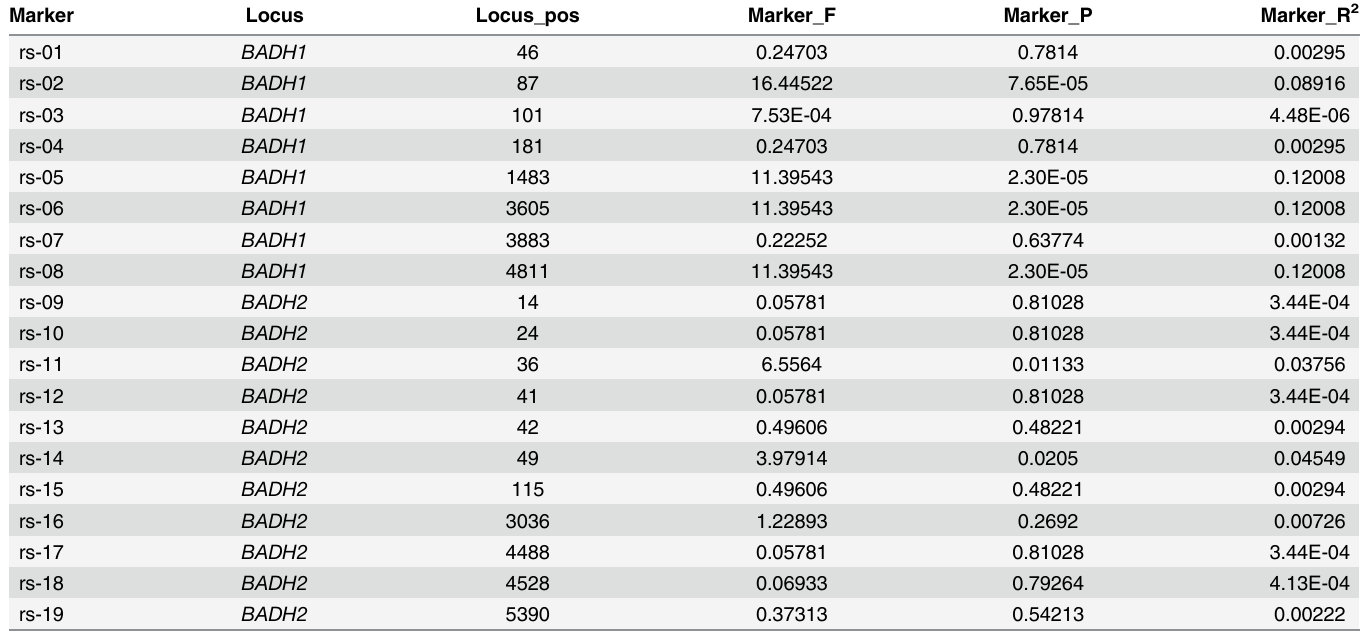
Locus_pos: Physical distance from the transcription initiation site of the